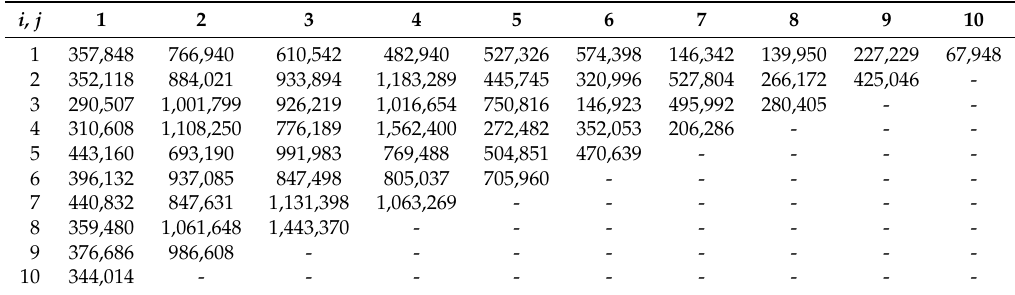
Table A2. Insurance run-off triangle taken from Taylor and Ashe (1983) as used in the empirical application in Section 6.3 and the simulations in Section